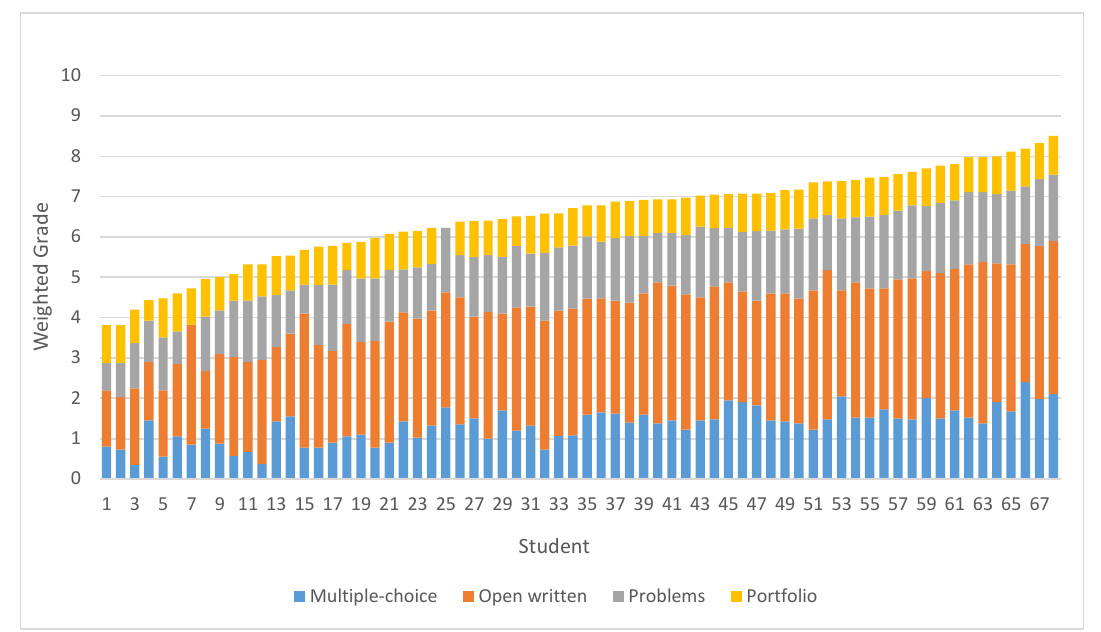
Figure 3. Students’ grades in the course on energy markets during 2021–2022.